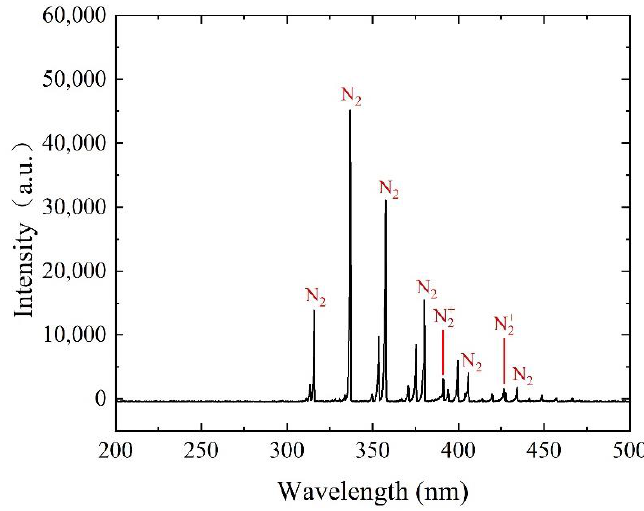
Figure 7. Optical emission Spectroscopy of the plasma.